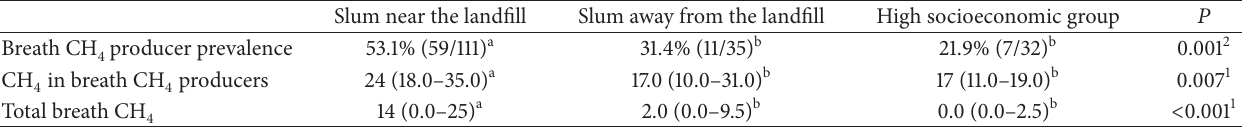
producers and children breath CH 4